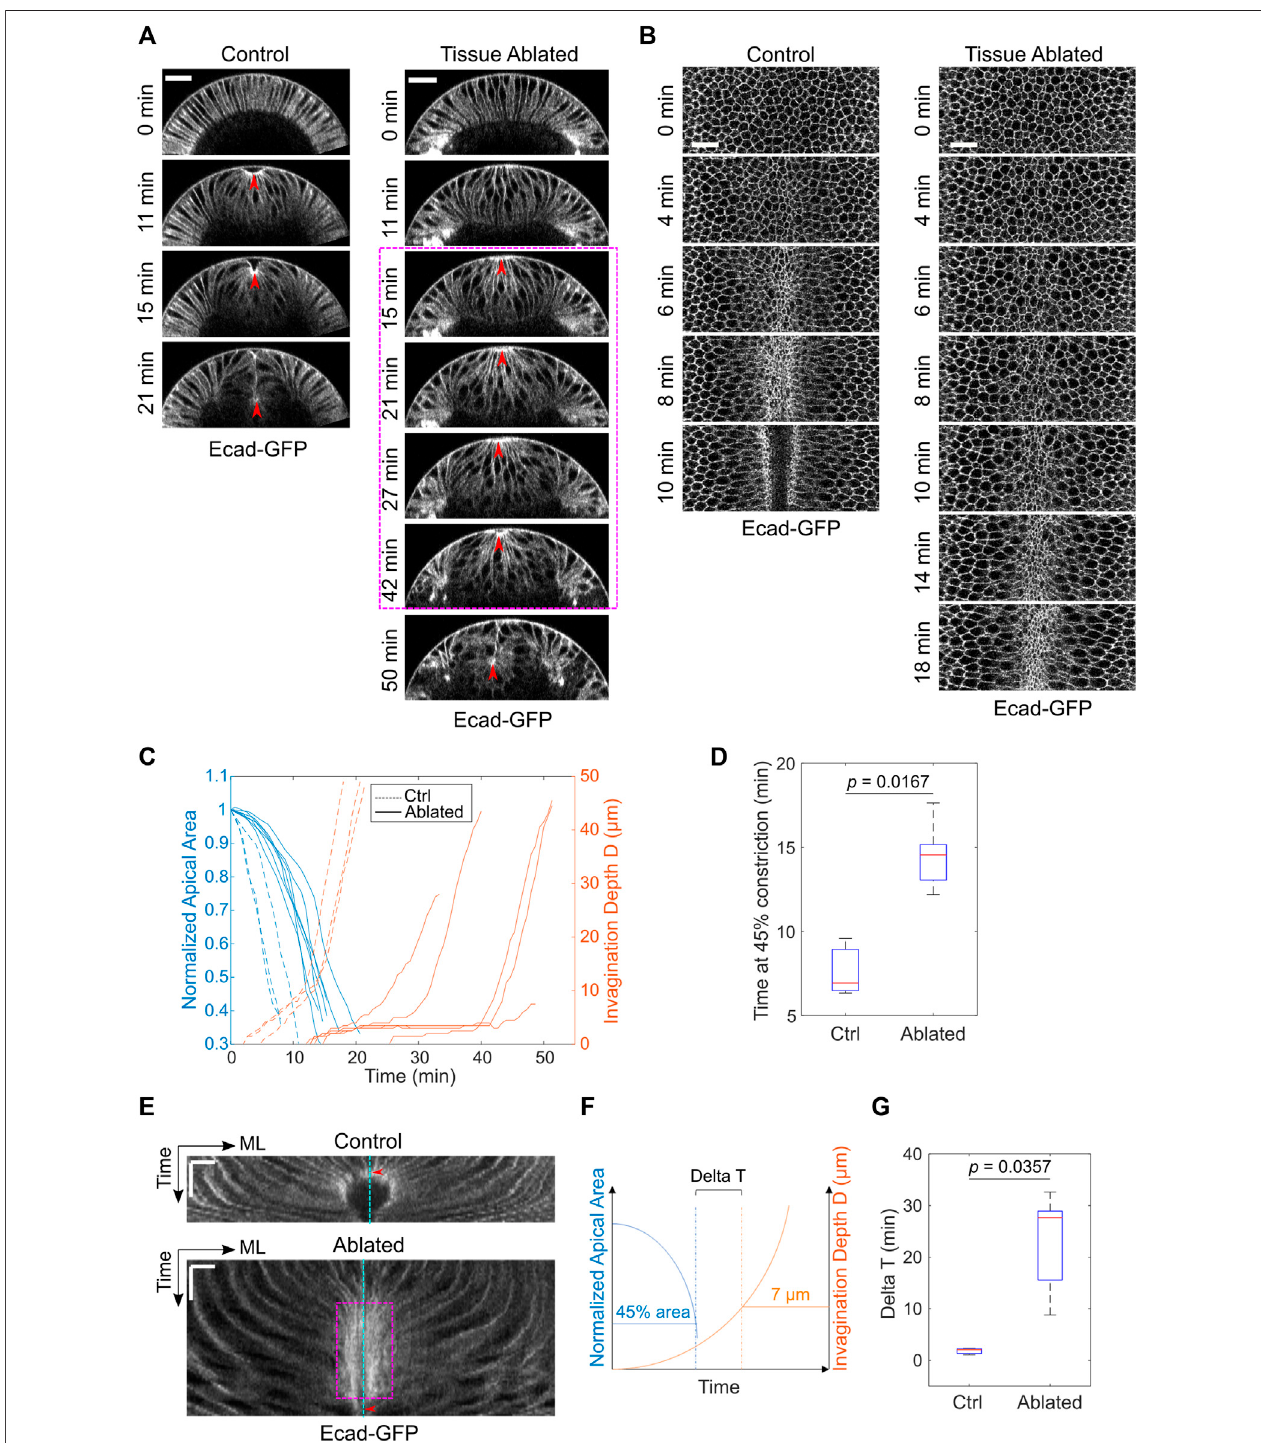
FIGURE 2 | Laser disruption of the lateral ectoderm results in a pause of mesoderm invagination at T trans . (A) Cross-section views showing the delayed ventral furrow invagination in ablated embryos. Red arrowheads indicate the apex of the ventral most cells. Magenta box highlights the pause near T trans . Scale bars: 25 μ m. (B) Surface projectionviewsshowingapicalconstrictionincontrolandectoderm-disruptedembryos.Scalebars:20 μ m. (C) InvaginationdepthDandtheapicalareaoftheconstrictingcellsin control ( N = 3) and ablated ( N = 7) embryos during the course of ventral furrow formation. (D) Time for the constricting cells to achieve 45% constriction after the onset of gastrulation in control and ectoderm-disrupted embryos. (E) Kymographs of apical cell membrane on the ventral surface illustrating the pause near T trans in ectoderm-disrupted